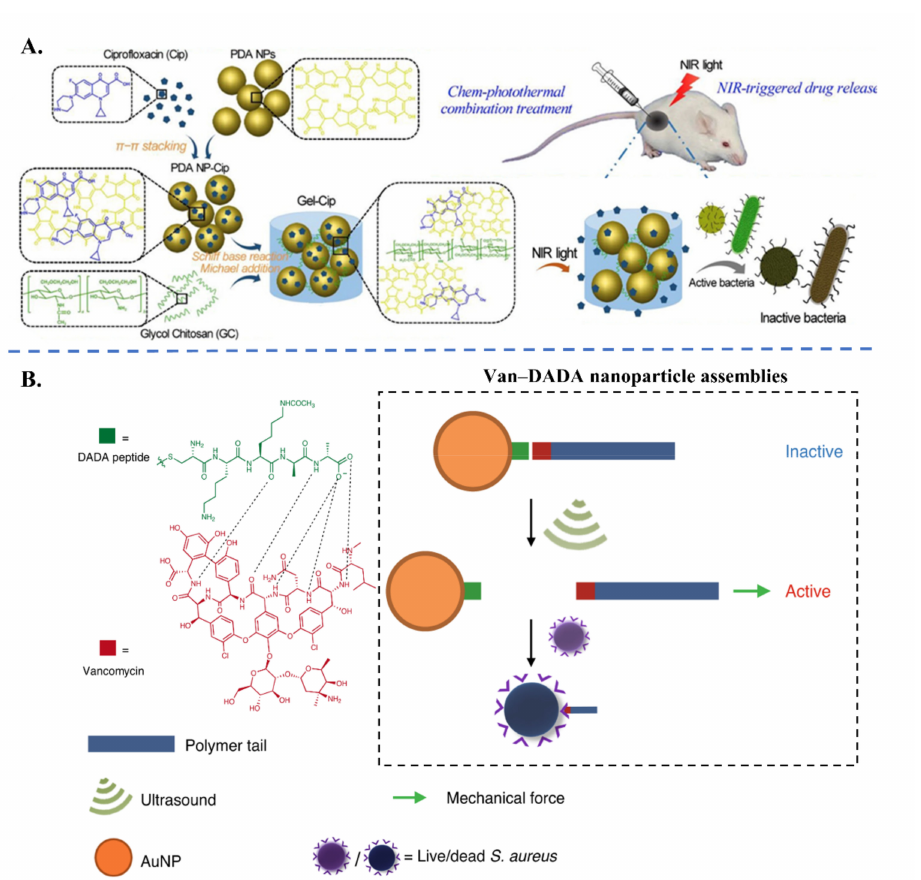
Figure 6. Examples of exogenous stimuli-responsive nanocarriers for antibiotic delivery. ( A ) Schemat- ics of the synthetic route of a NIR-controllable on-demand antibiotics’ release system using poly- dopamine nanoparticles (PDA NPs) for bacterial inactivation (reprinted with permission from [77], copyright 2019 Elsevier). ( B ) Schematic depiction of ultrasound activation of antibiotic assembled nanosystem. Van-DADA peptide assemblies activate the antibiotic properties of vancomycin to kill bacteria by ultrasound (adapted with permission from [80], copyright 2021 Springer